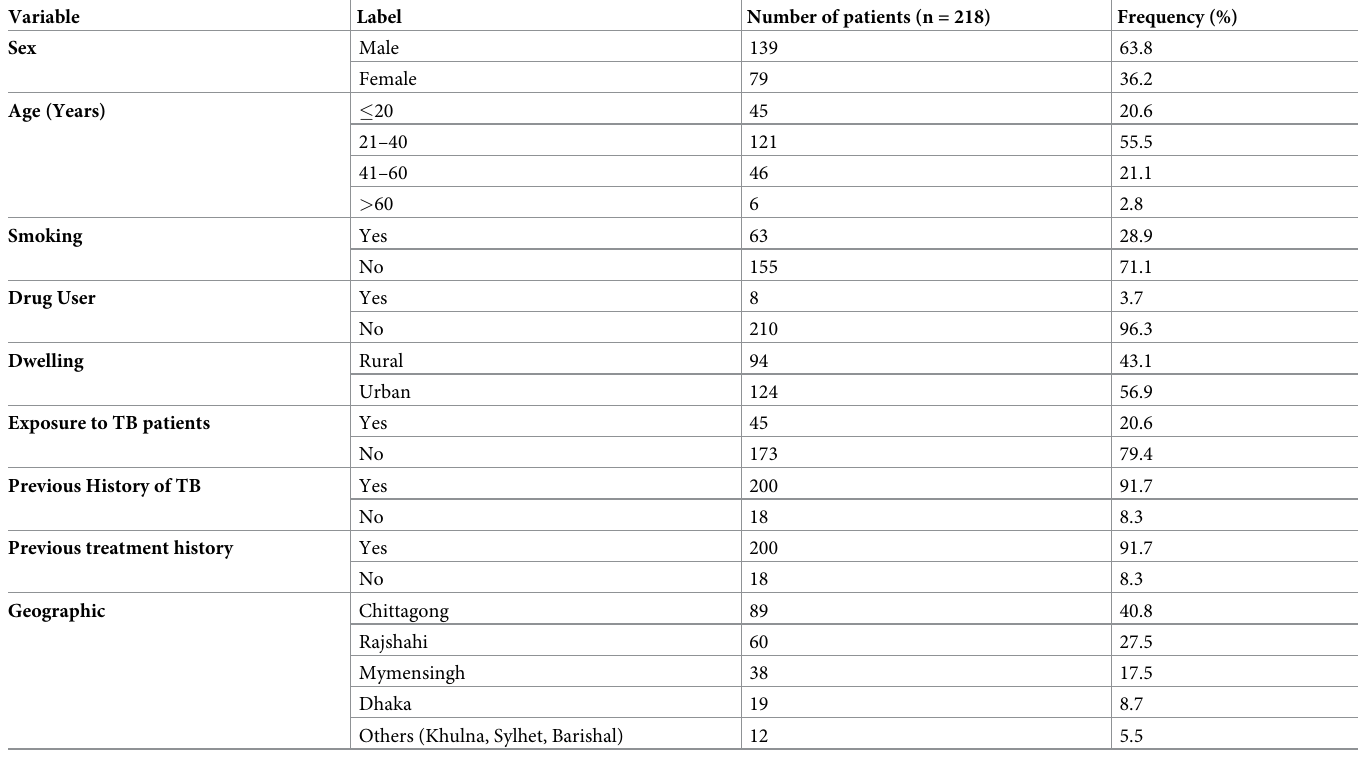
Table 1. Demographic and clinical characteristics of 218 MDR-TB patients.